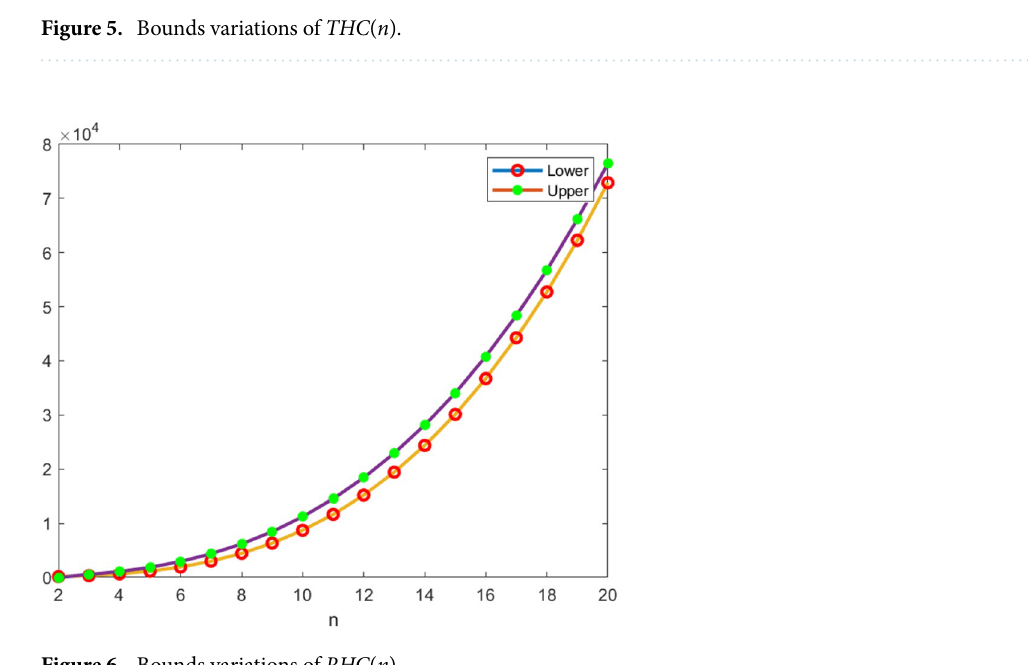
Figure 6. Bounds variations of RHC ( n